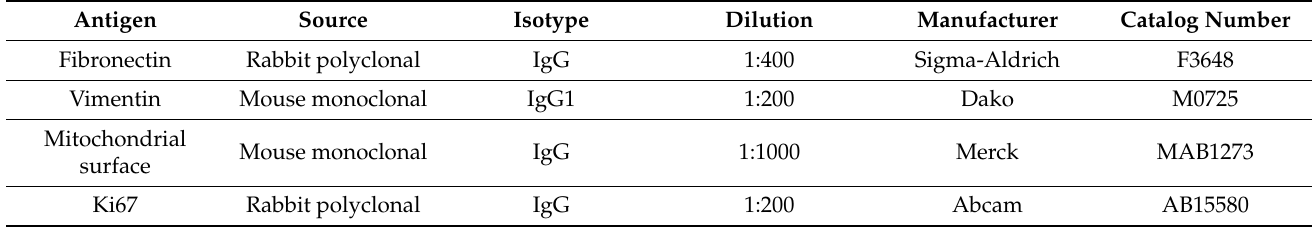
Table 1. Primary antibodies used for immunocytochemistry analysis.